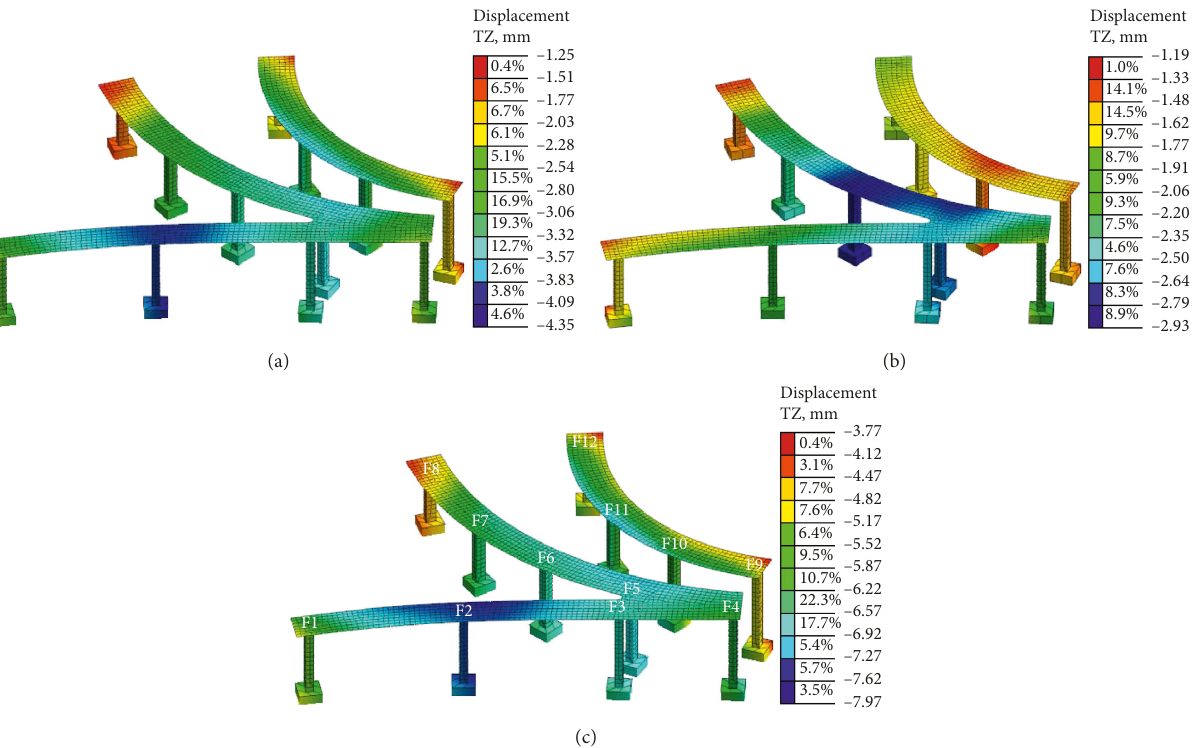
Figure 12: Calculated settlement of bridge: (a) deep-hole grouting; (b) pile foundation underpinning; (c) without protection. The values (in red characters) represent the percentage of displacement. For an example, the red area in Figure 12(c) (displacement between − 3.77 mm and − 4.12mm) accounts for 0.4% of the total displacement of the